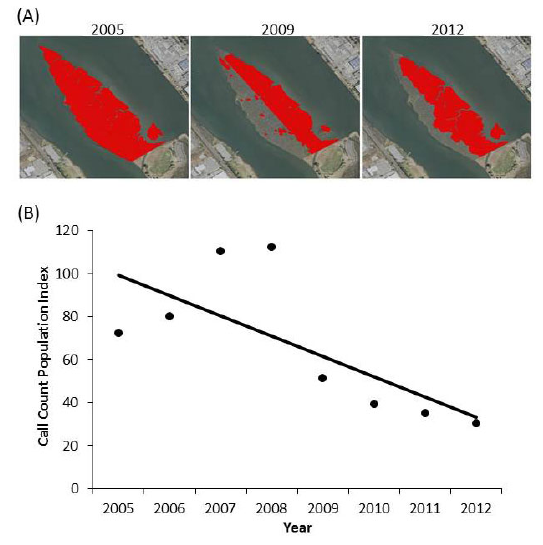
Fig. 5 . Extent of habitats dominated by invasive Spartina delineated from aerial photography (shown in red) before treatment in 2005, after initial treatments in 2009, and after near eradication in 2012 (A); and call- count survey detections and trend (−9.4 birds per year) with Arrowhead Marsh